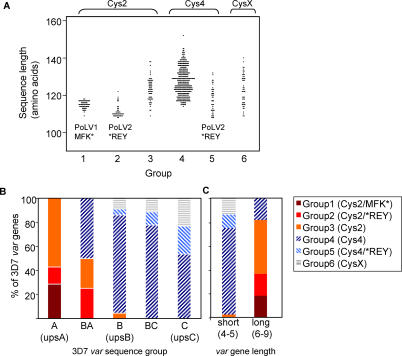
Sequence Groups(A) DBLα sequences were divided into six sequence groups: sequence groups 1–3 are those that contain two cysteine residues (cys2), and sequence groups 4 and 5 are sequences that contain four cysteine residues (cys4). Sequence group 6 includes sequences with one, three, five, or six cysteines (cysX). Sequence groups 2 and 5 contain PoLV2*REY. Sequence group 1 contains PoLV1MFK*. The length of each distinct DBLα sequence within each sequence group is indicated.(B and C) The distribution of 3D7 var genes in each DBLα sequence group among groups previously defined on the basis of coding and upstream non-coding regions of full-length var sequences [1,33] (B) and the overall length of the genes (C). Genes are classified as short if they have 4–5 domains and long if they have 6–9 domains (see Text S6).